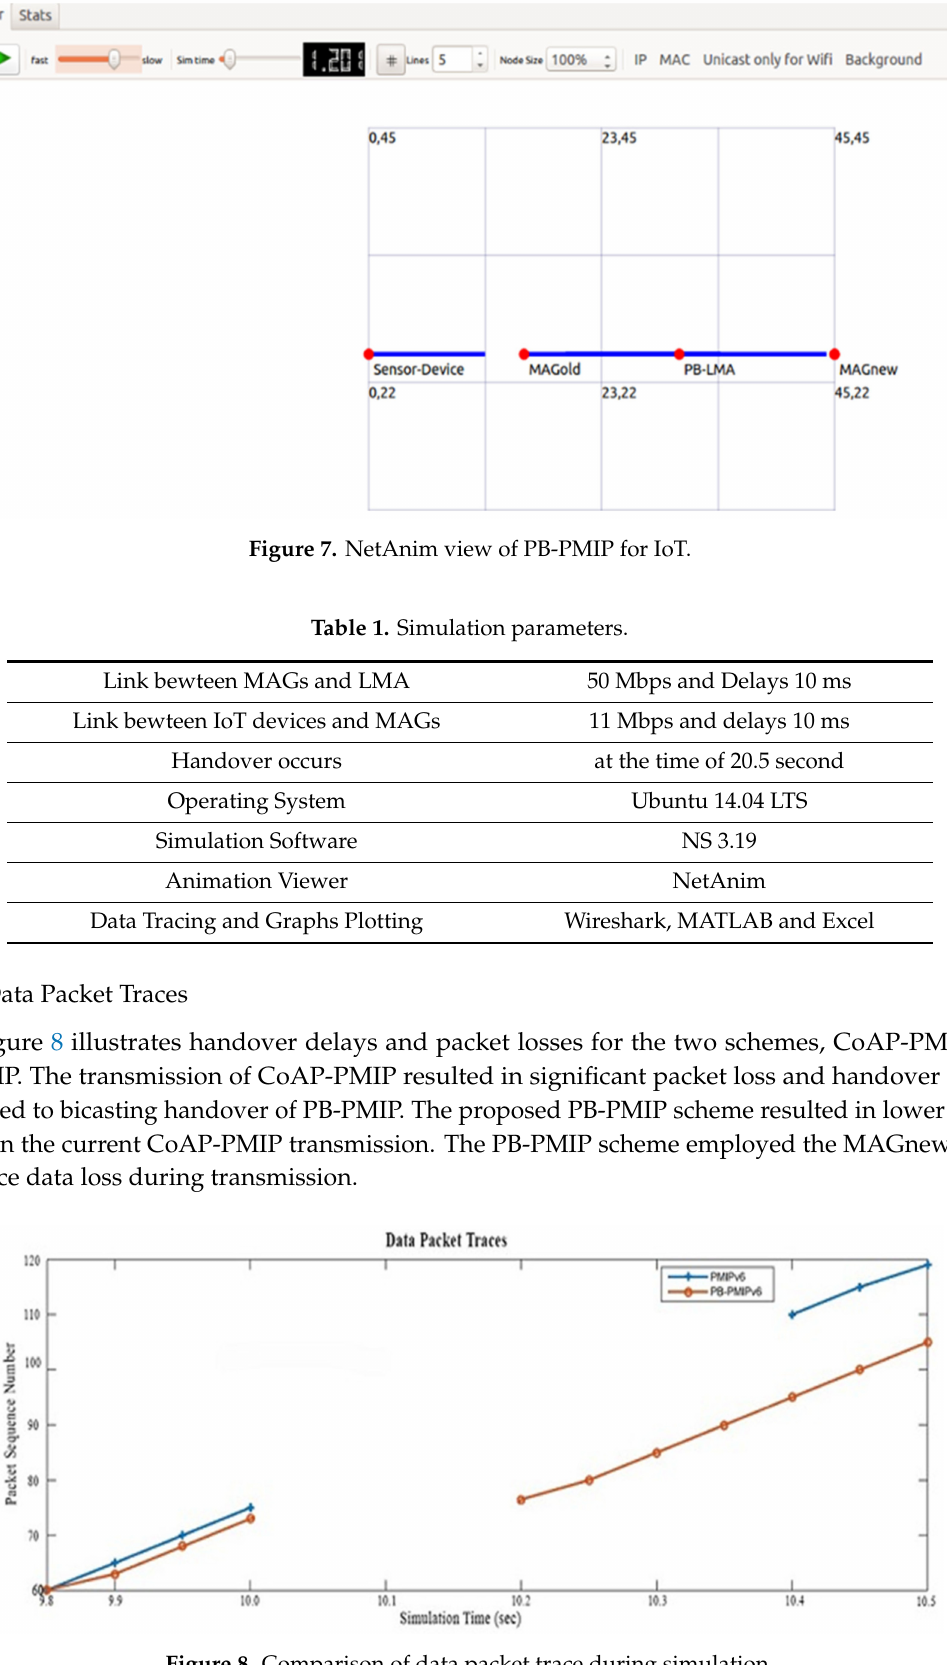
Figure 8. Comparison of data packet trace during